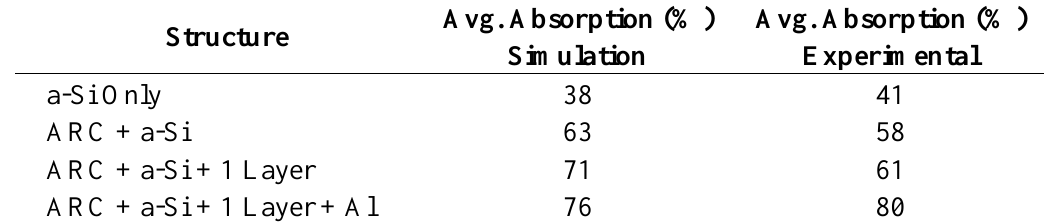
Table 3. Final values of the average absorption for different structures over the entire 400–800 nm range.